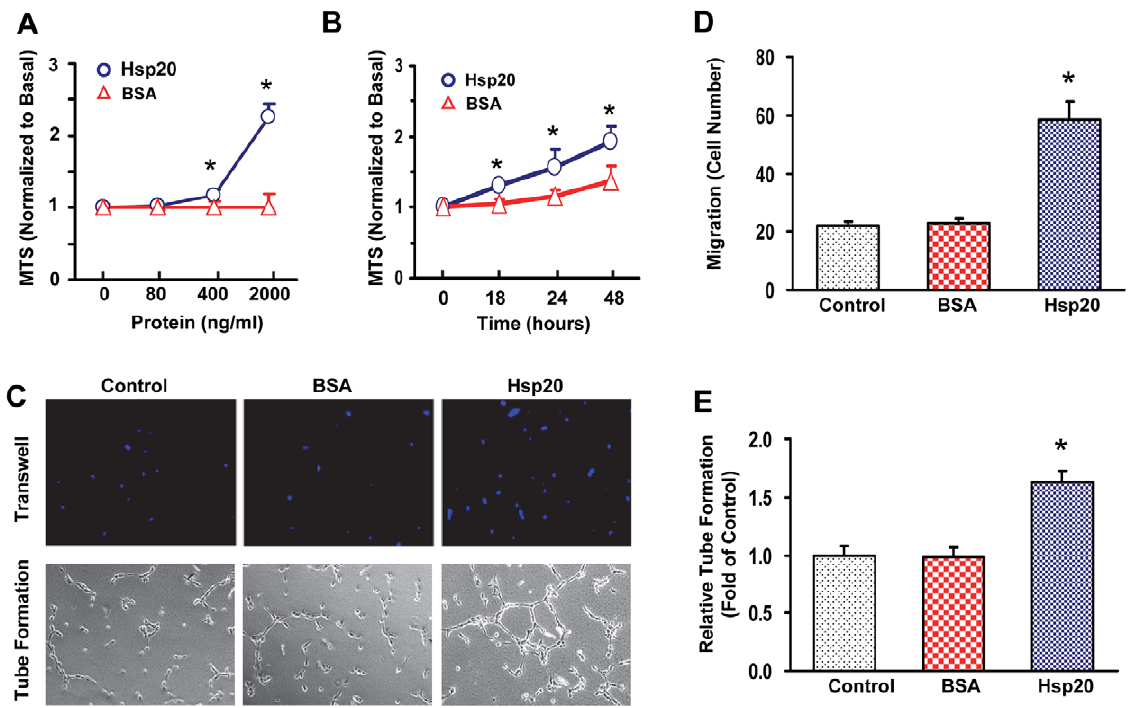
Figure 4. Hsp20 stimulates HUVEC proliferation, migration and capillary-like tube formation. (A) Recombinant human Hsp20 protein was added to HUVECs at various doses (80–2000 ng/ml) for 24 h. BSA was used as a control. Cell proliferation was determined by MTS. (B) Time- course effects of the Hsp20 protein(1000 ng/ml) on the HUVEC proliferation. (C) Representative photographs indicated the effects of recombinant human Hsp20 protein on the trans-well and tube formation of HUVECs. (D) Migration was quantified by counting cells that were moved through the membrane (Trans-well assay). (E) Tube formation was evaluated by the measurement of relative tube length. Similar results were observed in three additional, independent experiments (*, p , 0.05 vs. Control).